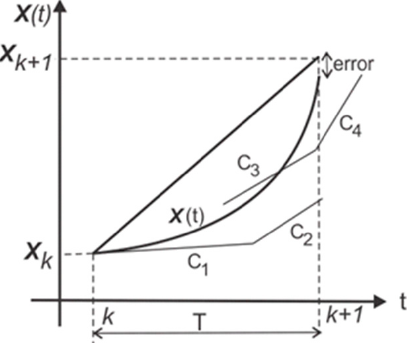
Figure 5. Approximation using Runge–Kutta method.